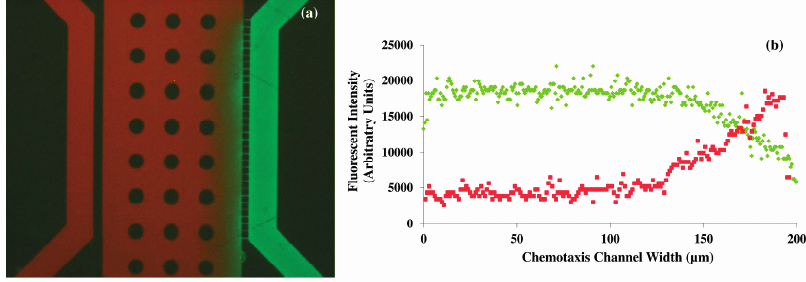
Figure 1. Diffusion assay microfluidic device characterization. ( a ) Representative overlaid fluorescent image showing the concentration gradient of fluorescein and Texas Red dyes; ( b ) Diagram showing the averaged pixel intensity of the dyes across the center channels width. Both dyes were flowed through the device at rates of 30 μ L/h. Reproduced from [14] with permission from the Royal Society of